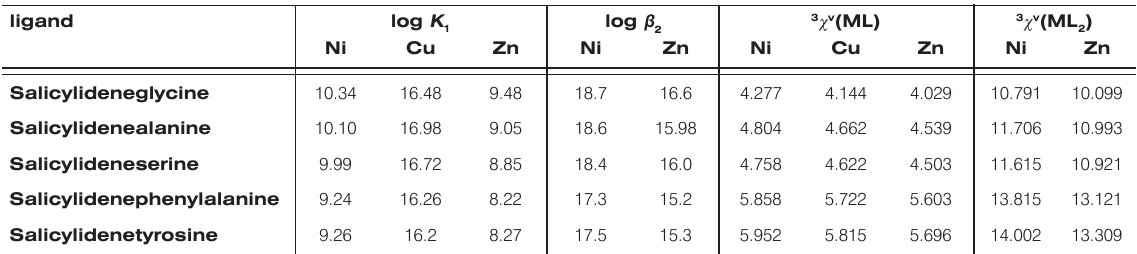
Table 2. Regression models for the estimation of the log K